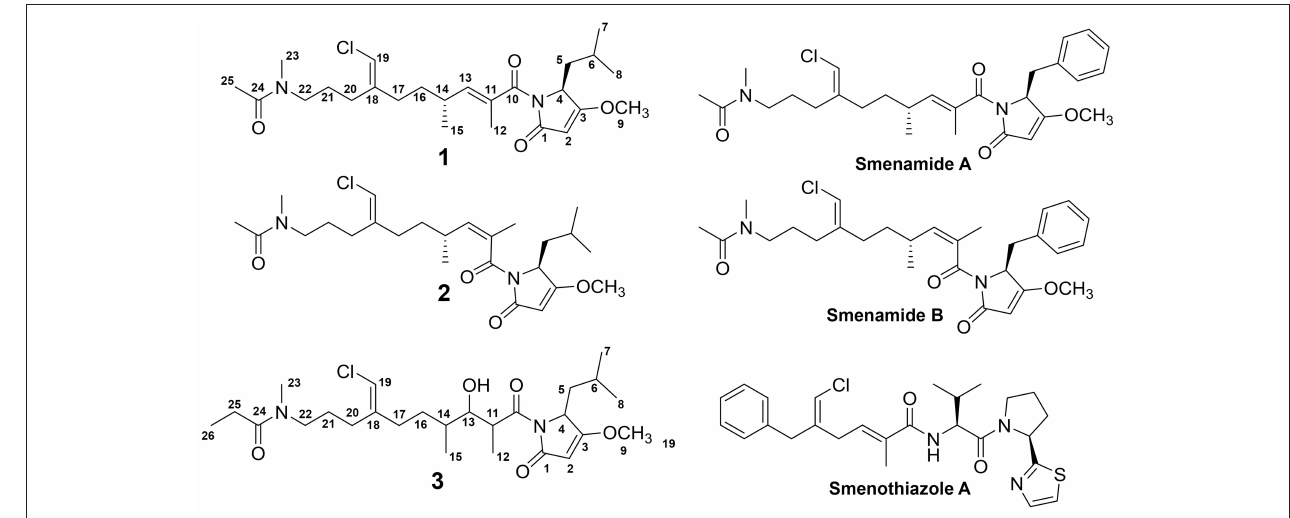
FIGURE 1 | Structures of 1-3 , smenamides A and B and smenothiazole A.